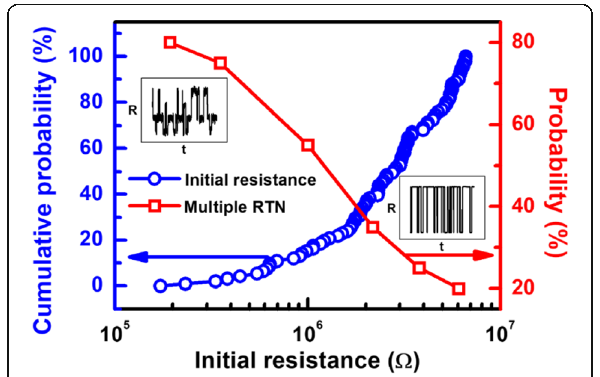
Fig. 12 The correlation between the initial resistance level and RTN level on CRAM cells is summarized. Higher probability of bi-level resistance fluctuation is expected to occur for cells with one dominant conductive path, which correlated strongly with cells of high R ini